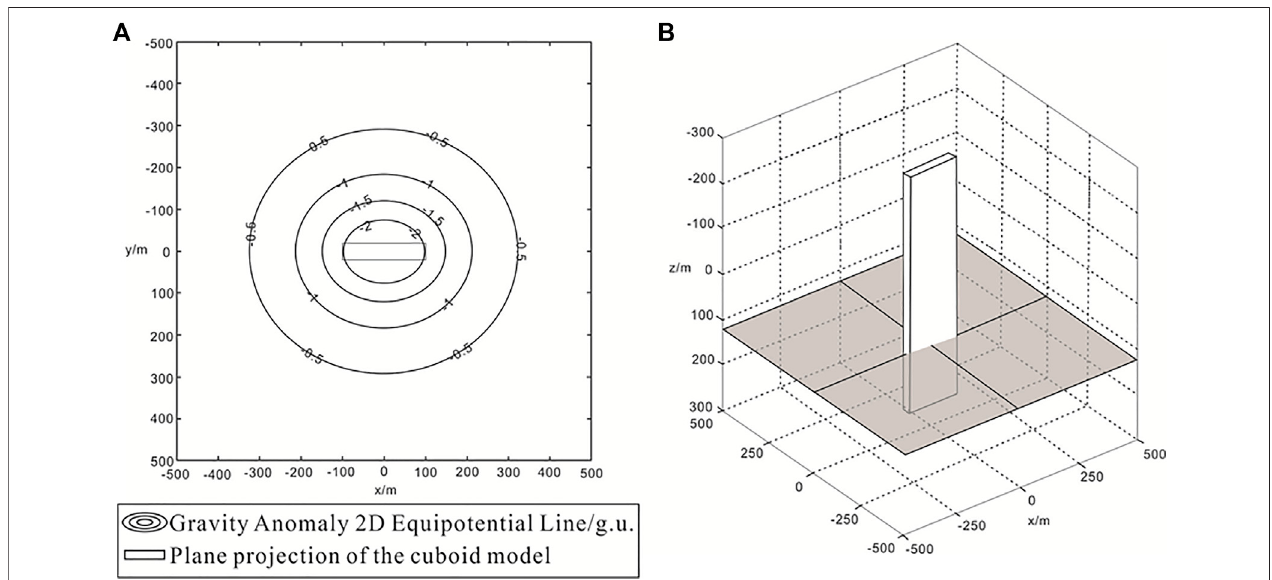
FIGURE 6 | Contour map of the gravity anomaly on the observation plane at z = 125 m.